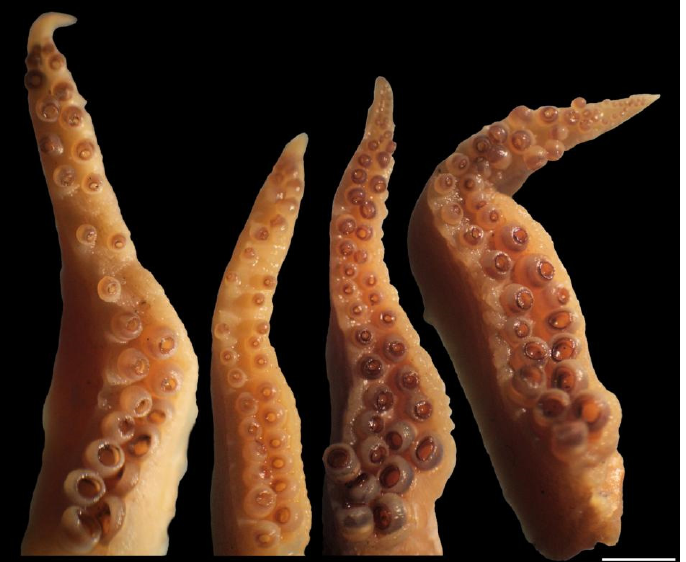
Figure 16. Sepia typica variation in unmodified right arm IV p of males. From left to right: SAIAB 211659, ML 25 mm, Northwest Area; SAIAB 211640, ML 19 mm, Northwest Area; SAIAB 211586, ML 22 mm, Eastern area; SAIAB 211582, 18 mm, Eastern area. Scale bar 2 mm.